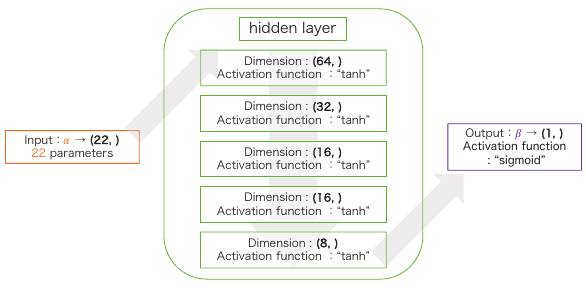
Figure 5: Machine learning model outline